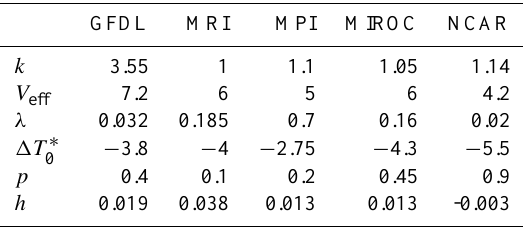
Table 2. Results of the parameter optimisation. Values are